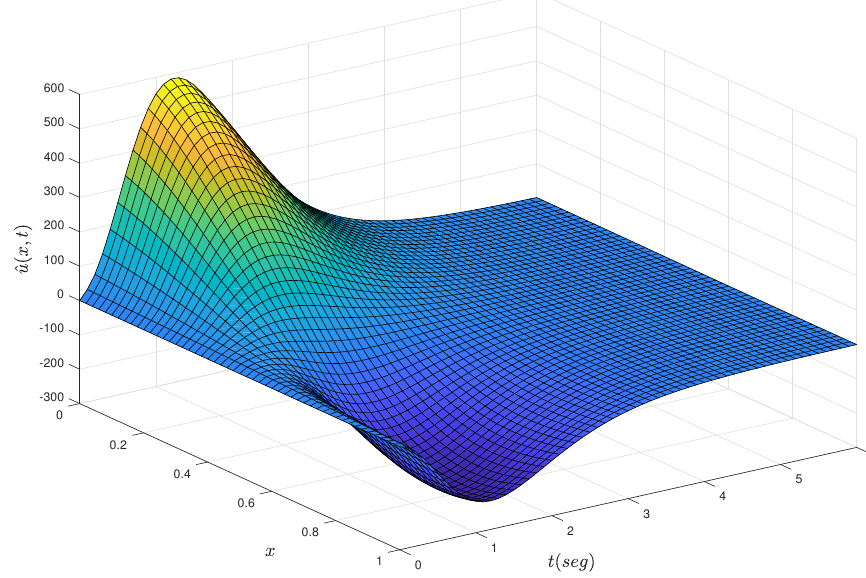
Figure 3. Dynamics of the identifier